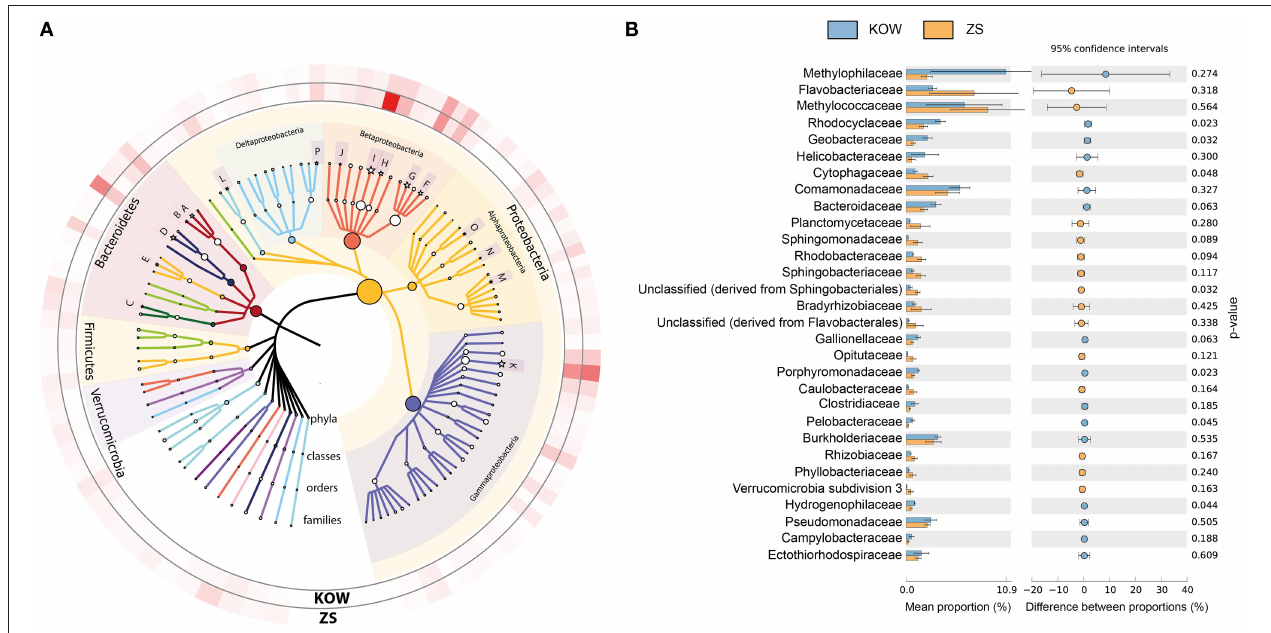
FIGURE 4 | Most abundant families found in the analyzed microbial mats. (A) Phylogenetic tree of the most abundant families identified in analyzed metagenomes. The size of tree node represents the abundance of a particular taxon in the analyzed metagenomes. Families with significant differences between analyzed metagenomes are marked with a star. On the outer ring, family abundances are showed as a heatmap. A, Bacteroidaceae ; B, Porphyromonadaceae ; C, Sphingobacteriaceae ; D, Flavobacteriaceae ; E, Cytophagaceae ; F, Burkholderiaceae ; G, Comamonadaceae ; H, Rhodocyclaceae ; I, Methylophilaceae ; J, Hydrogenophilaceae ; K, Methylococcaceae ; L, Helicobacteraceae ; M, Bradyrhizobiaceae ; N, Sphingomonadaceae ; O, Rhodobacteraceae ; P, Geobacteraceae (B) Families differing in abundance between analyzed communities. p -values calculated in STAMP using Welch’s test, with no correction